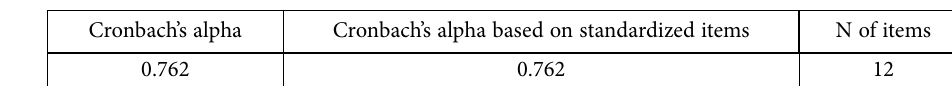
Table 1. SPSS  , Reliability Statistics